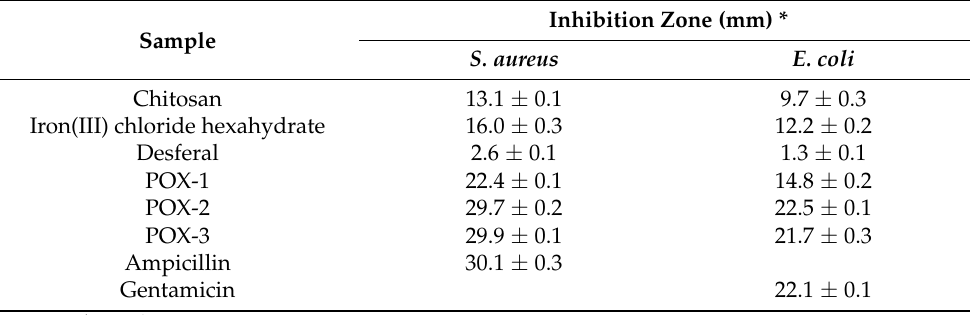
Table 2. Antibacterial effects of the elaborated